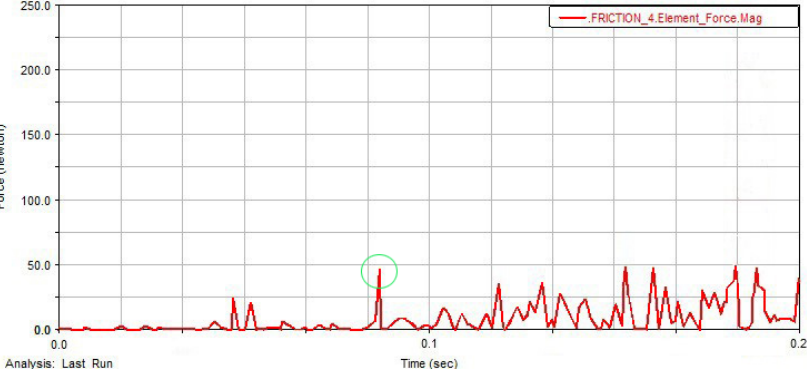
Figure 13. Comparison of friction between slider and rotor slider slot before stator optimization.